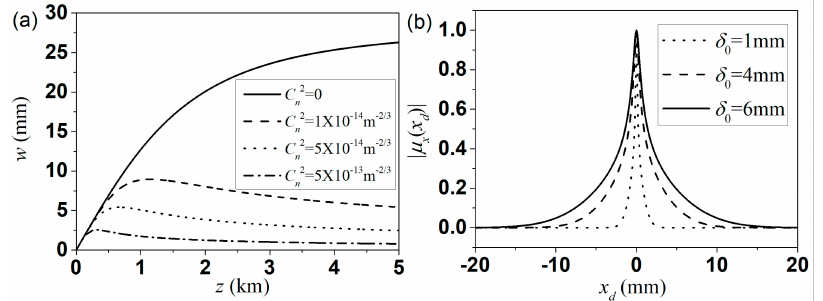
Figure 3. ( a ) Evolution of the parameter w with propagation distance for different structure constants. ( b ) One-dimensional (1D) distribution of the modulus of the degree of coherence (DOC) with different coherence widths in the source